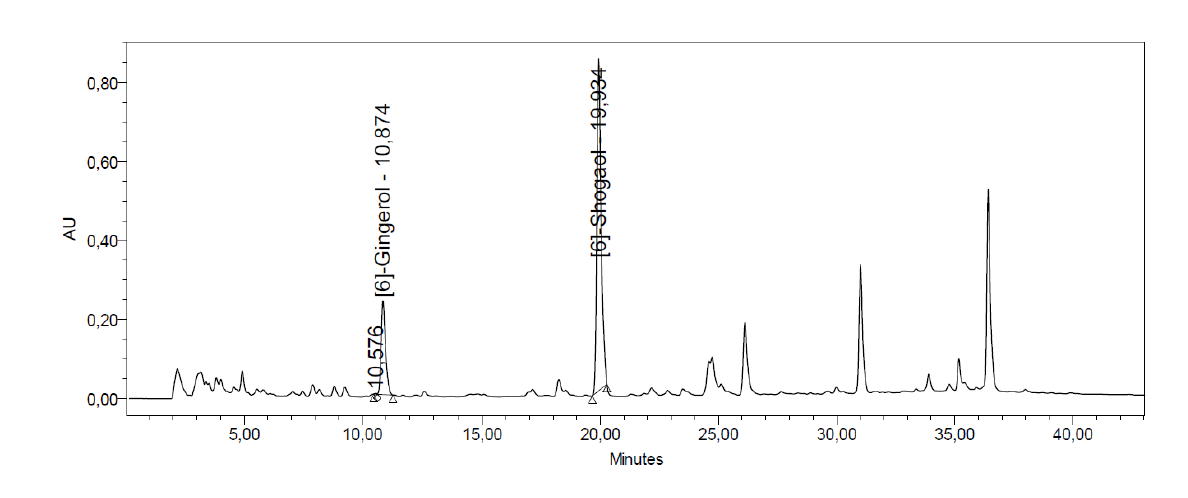
Fig. 3. The first food supplement„s (FS_1)